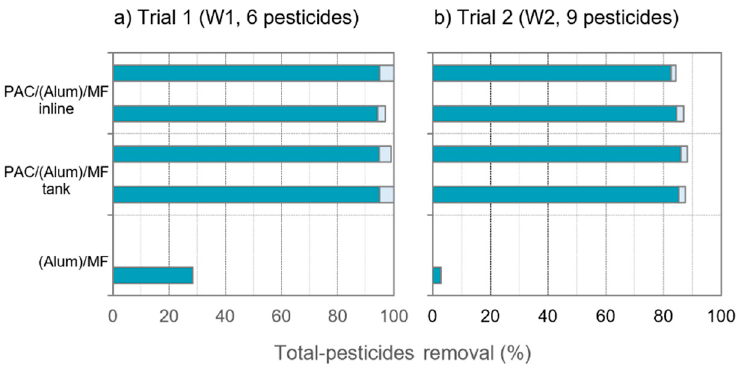
Figure 5. Total pesticides’ removal in trial 1, with W1 spiked with 6 pesticides ( a ) and in trial 2 with W2 spiked with 9 pesticides ( b ) (total-pesticides concentrations are given by summing the concentrations of all pesticides; due to some pesticides’ concentrations <LOQ in permeate, removals ranged between values computed with LOQ, represented in darker blue, and values computed with 0 µg/L, in light blue).